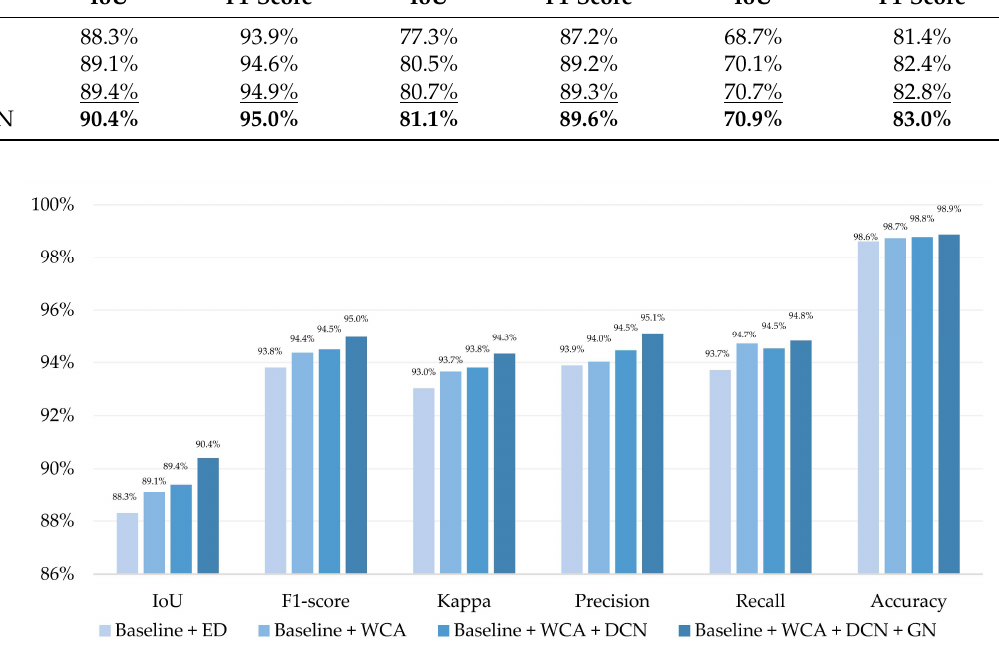
Figure 11. Ablation experimental results obtained on the WHU dataset.